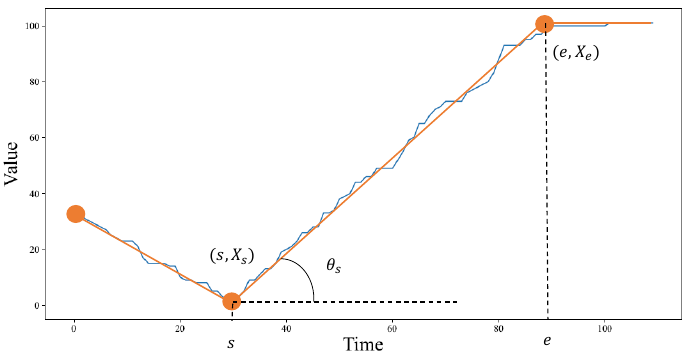
Figure 3. An illustration for the angle between the horizontal line and the new representa- tion